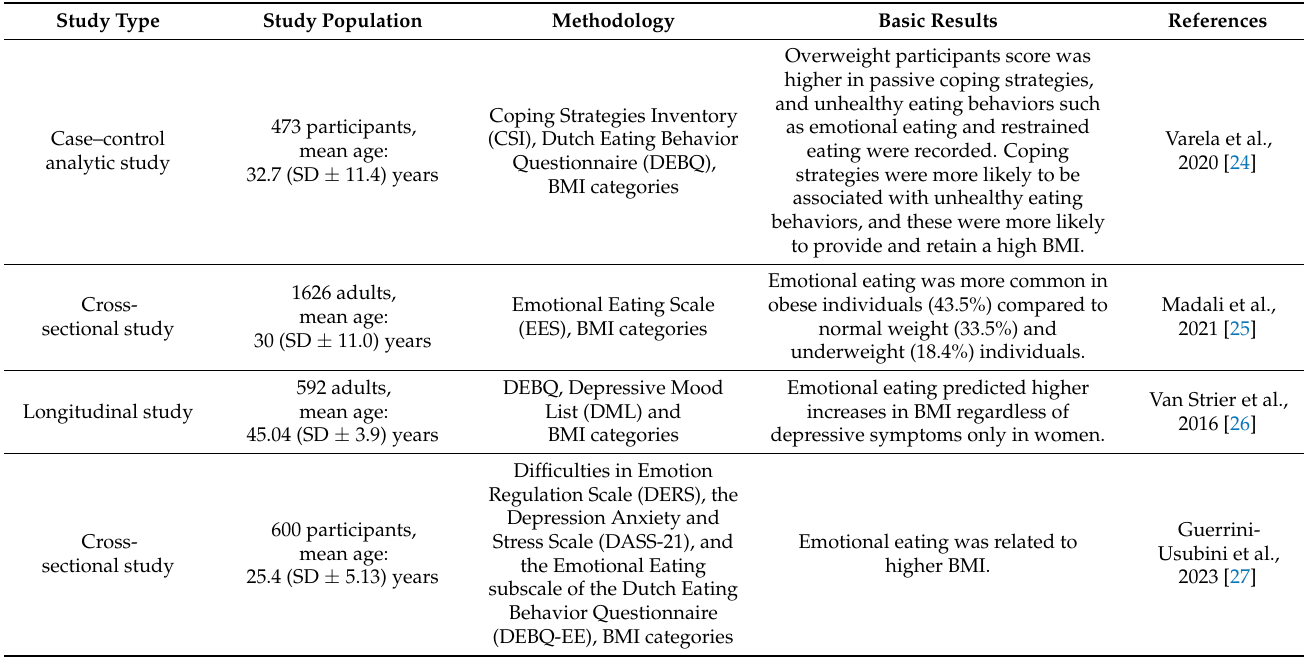
Table 1. Clinical studies evaluating the association of emotional eating with